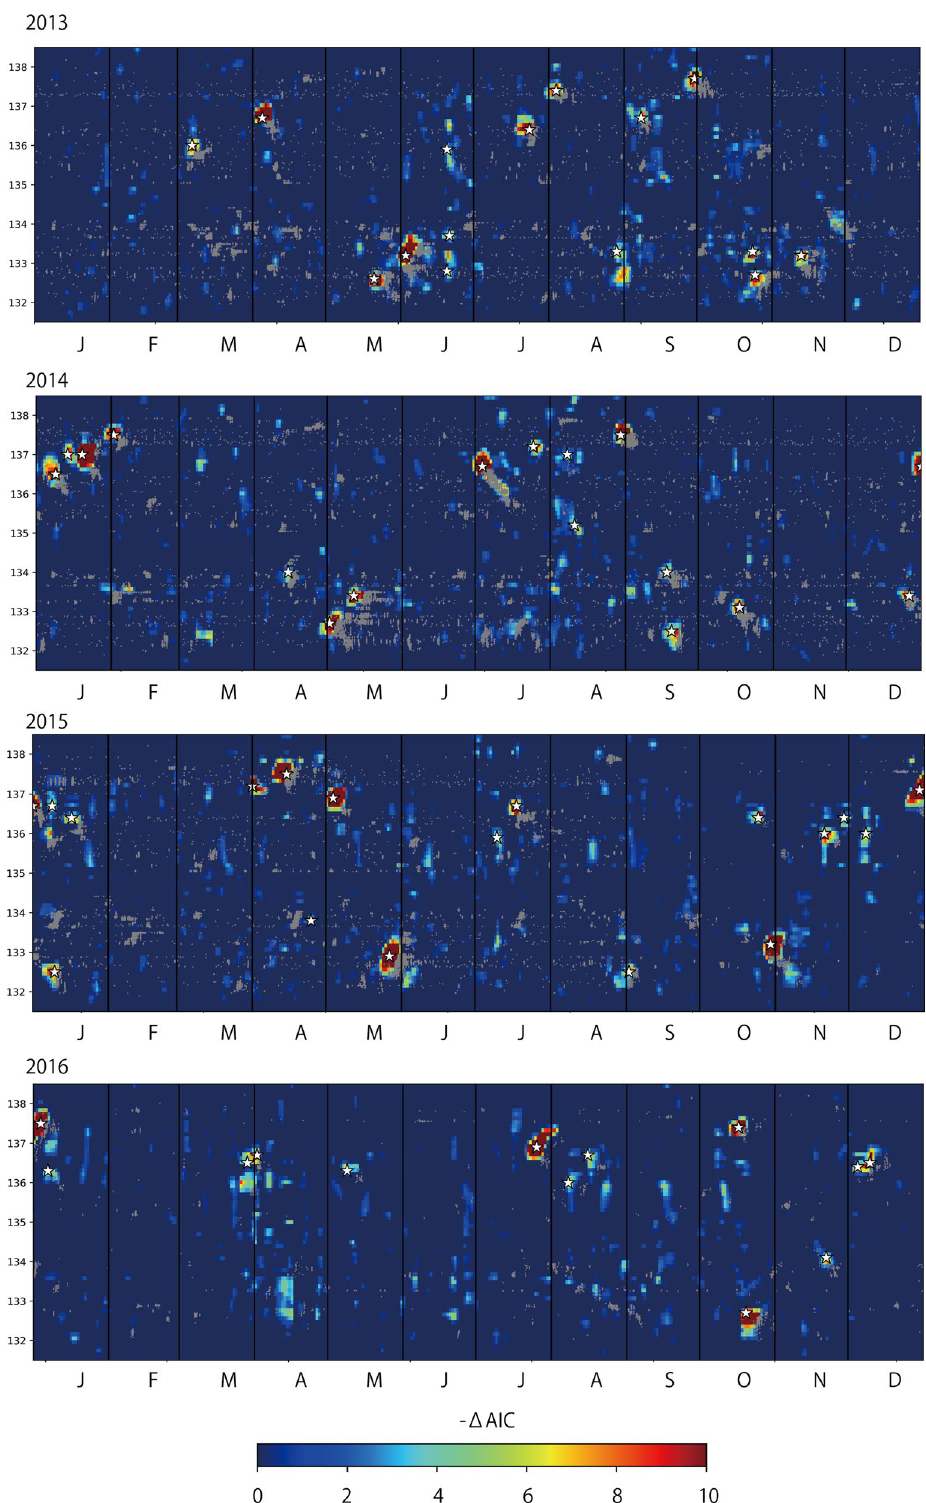
Fig. 4 Temporal–spatial distributions of the calculated ΔAIC. Background colors represent the calculated ΔAIC. White stars represent the timings and locations of events detected in this study. Gray dots are LFEs by JMA and Kato and Nakagawa